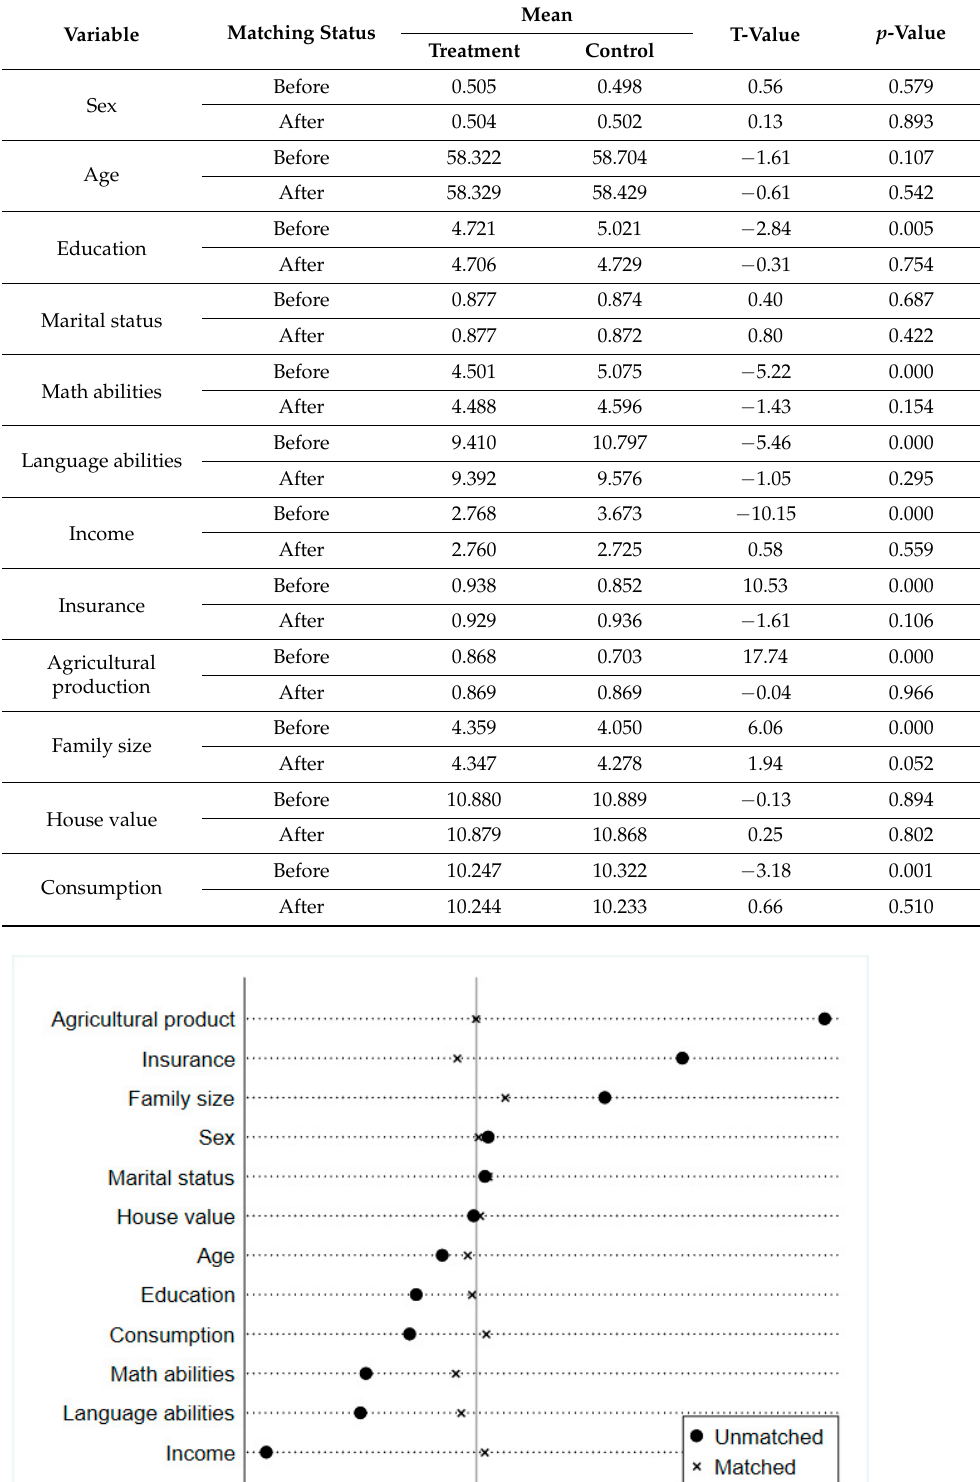
Table 4. The mean of covariates in treatment and control groups.